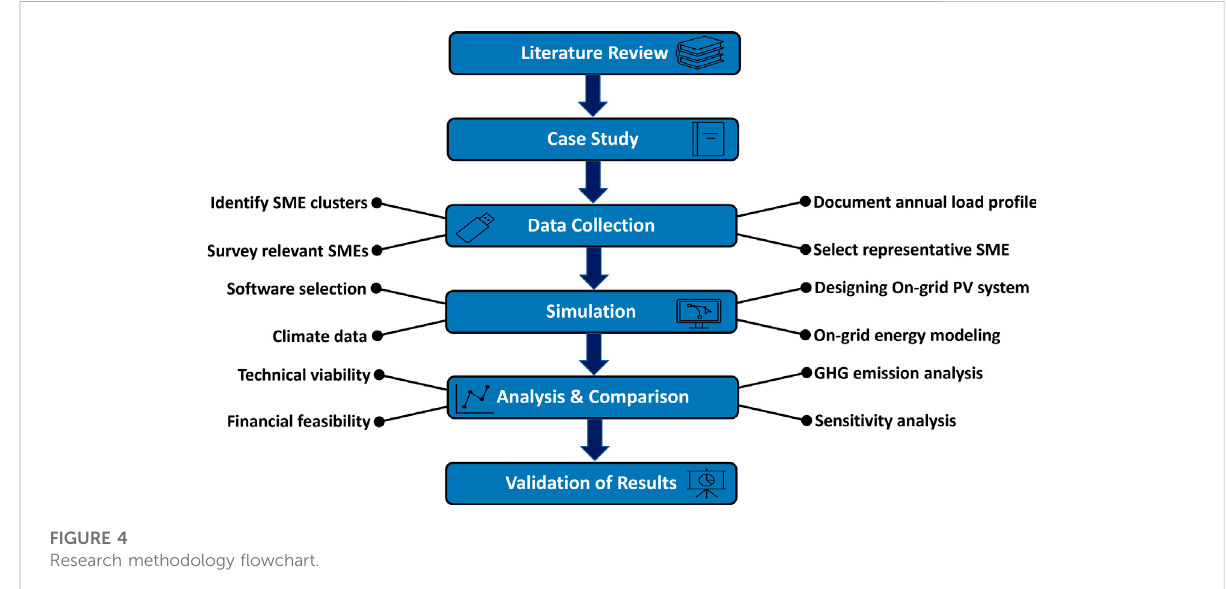
FIGURE 4 Research methodology fl owchart.